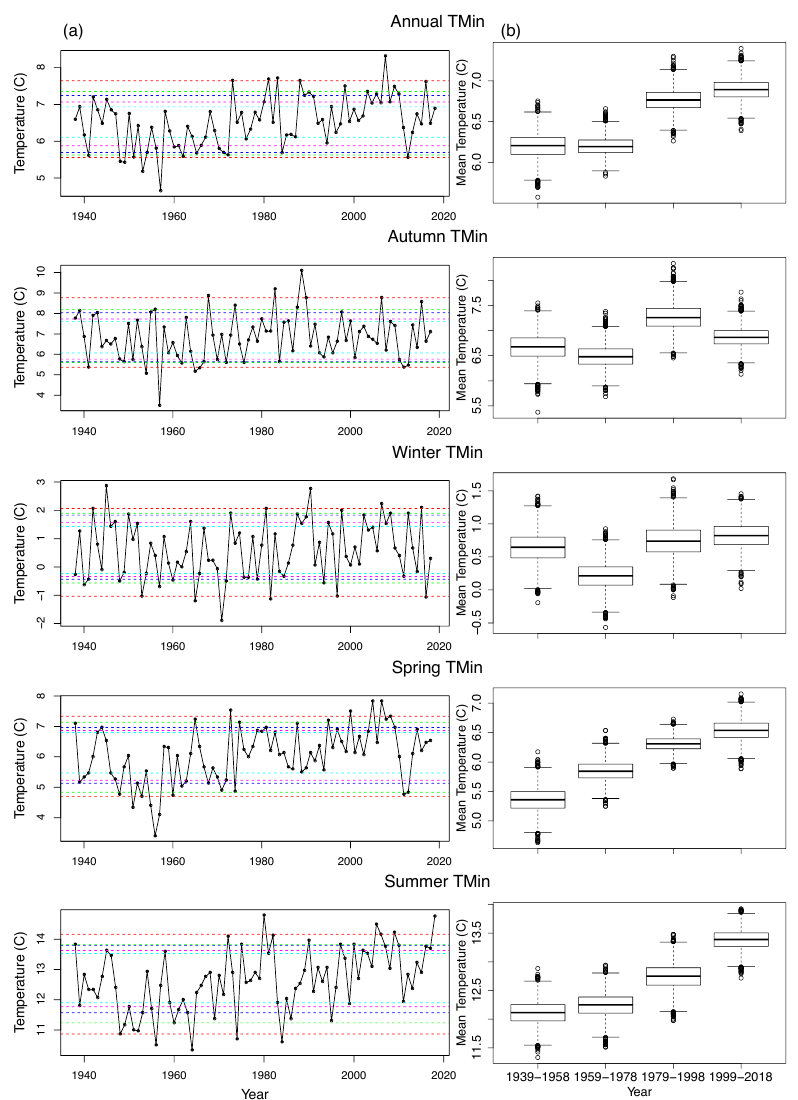
Figure 5. ( a ) Time series and ( b ) box plots as in Figure 3 except for